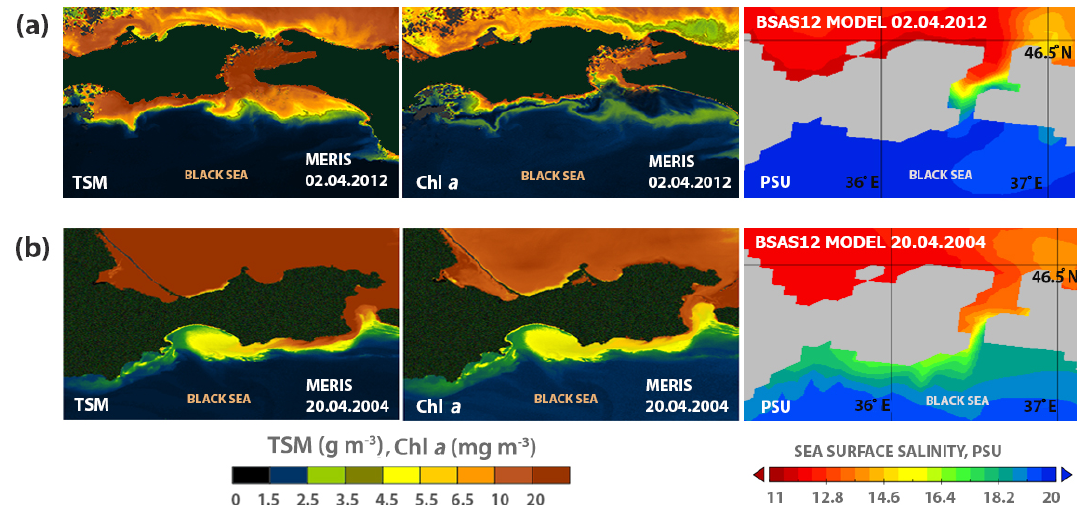
Figure 2. Sea surface distributions of TSM (left) and Chl a (middle) retrieved from MERIS satellite data and sea surface salinity distri- bution obtained from numerical modelling (right), indicating (a) wind-induced resuspension of sea bottom sediments at the study area on 2 April 2012 and (b) spreading of the AP on 20 April